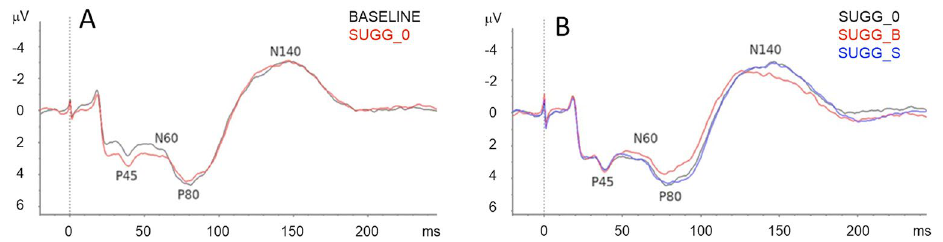
Figure 6. Grand-average waveforms. Recordings of the late SEPs in the Baseline and SUGG_0 condition ( A ) and in the three hypnotic conditions ( B ). Late SEP response peaks P45, N60, P80 and N140 are